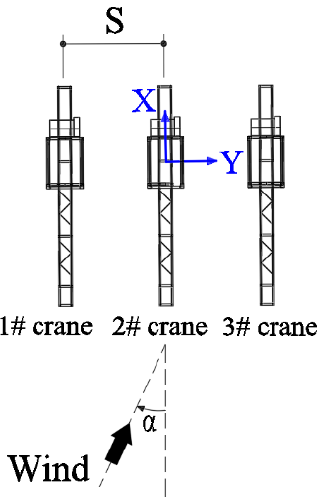
Figure 5. The top view of the group-arranged cranes.